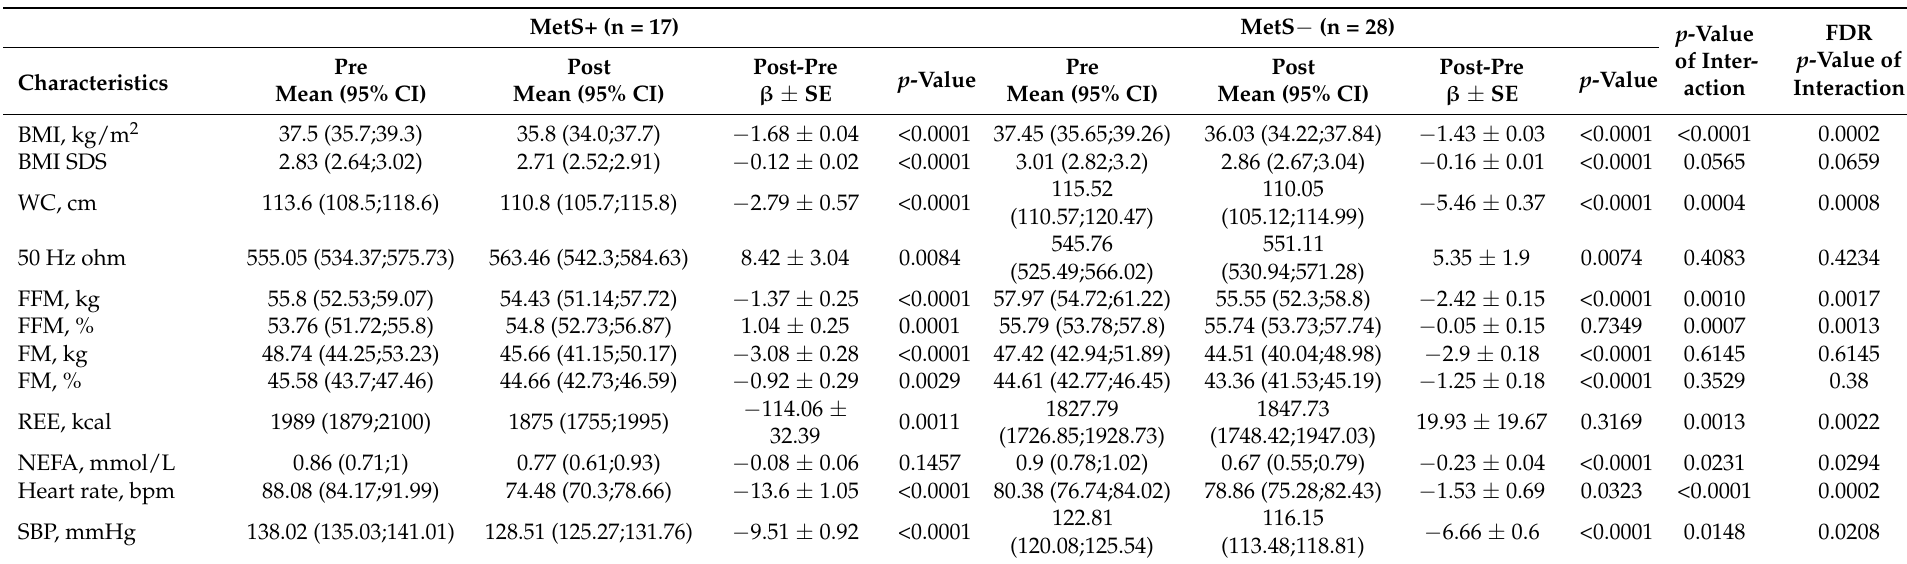
Table 4. Demographic, lifestyle, biochemical and clinical characteristics of study participants: pre- vs. post-BWRP comparison in subjects with (MetS+) or without (MetS-) metabolic